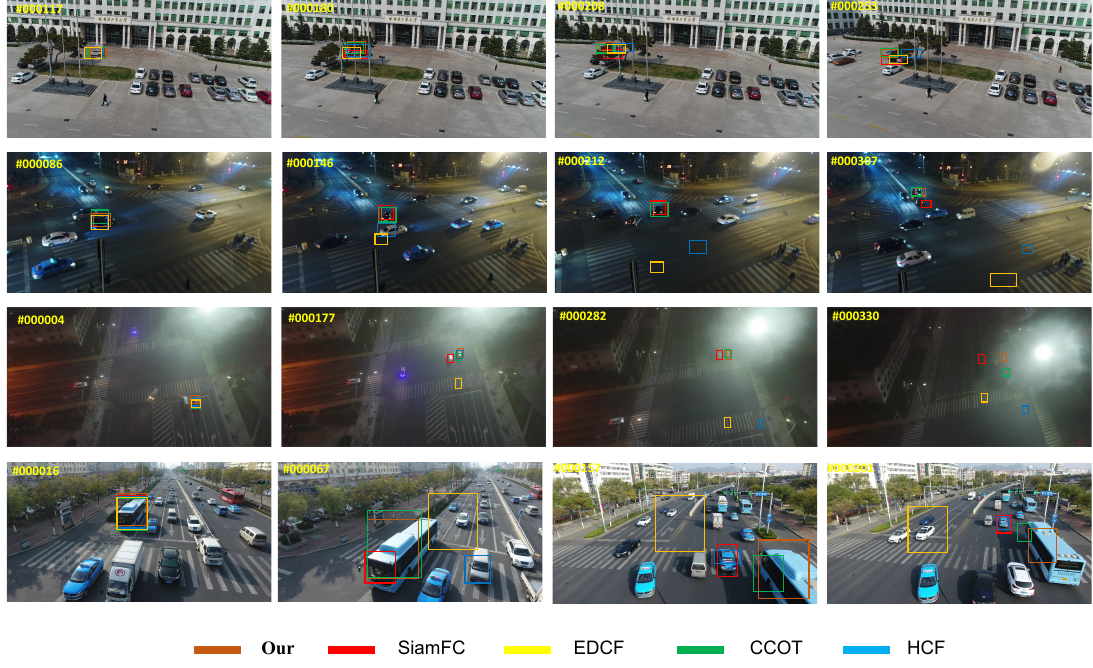
Figure 10. Experimental results of different trackers on challenging sequences (from top–down are S0201 , S0301 , S1306 and S0602 from the UAVDT [7] dataset). The tracking results of SiamFC [20], EDCF [19], CCOT [47], and HCF [37], as well as the proposed algorithm are denoted by different colored bounding